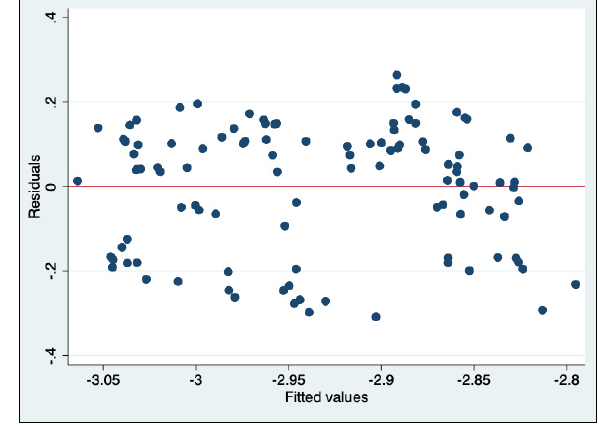
Residual versus fitted plot of pooled ordinary least squares regression. Residuals do not show any meaningful